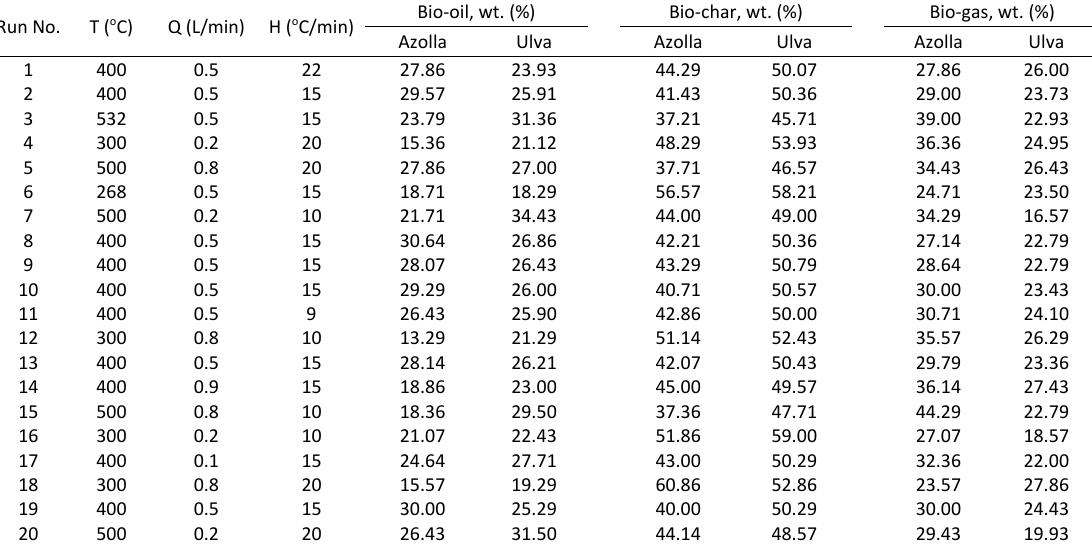
Table 3: Central composite design arrangement and responses for Azolla and Ulv